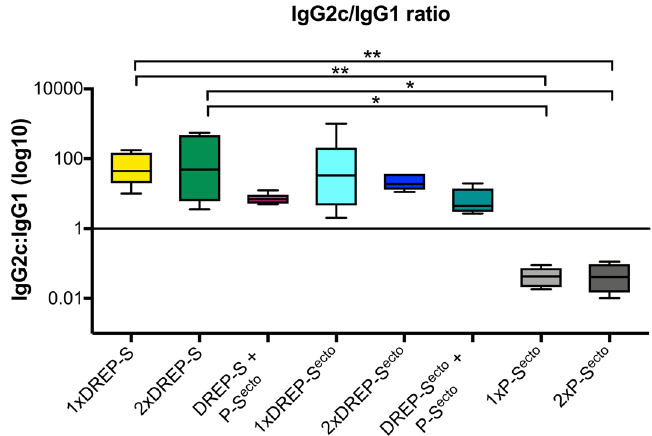
Figure 3. Anti-S SARS-CoV-2 antibody isotype analysis. Sera from mice immunized once or twice with DREP-S, DREP-S ecto or with the S ecto protein (n = 5/group) were analyzed by ELISA for anti-S ecto SARS-CoV-2 antibody isotypes IgG2c and IgG1. Results are presented as IgG2c:IgG1 endpoint antibody titer ratios against spike protein. A ratio above 1 indicates a Th1 biased response. Statistical analysis was performed using Kruskal Wallis test followed by Dunn’s test for multiple comparisons, * p < 0.05; ** p <